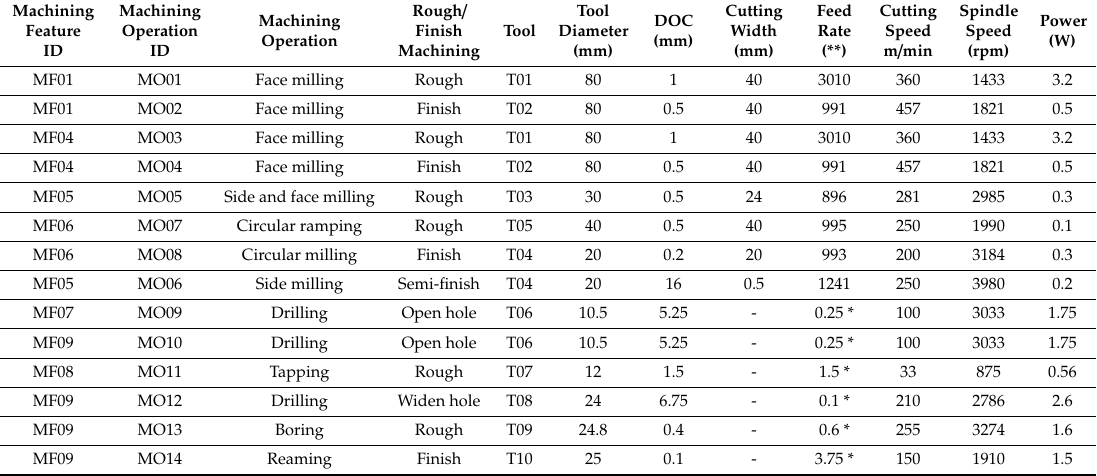
Table 5. Machining feature and technical requirement recognition results.